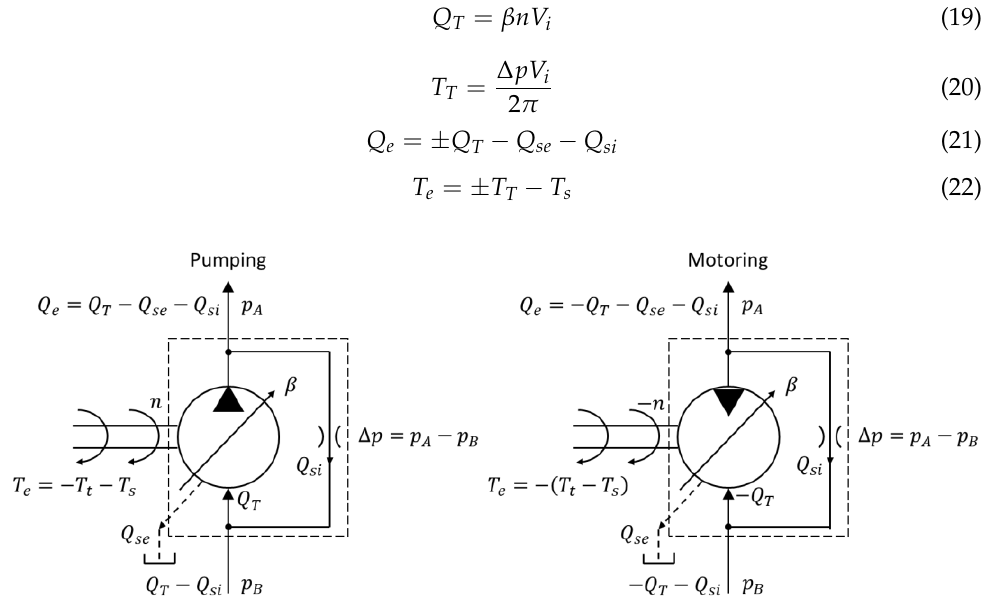
Figure 12. Pump/Motoring Model.